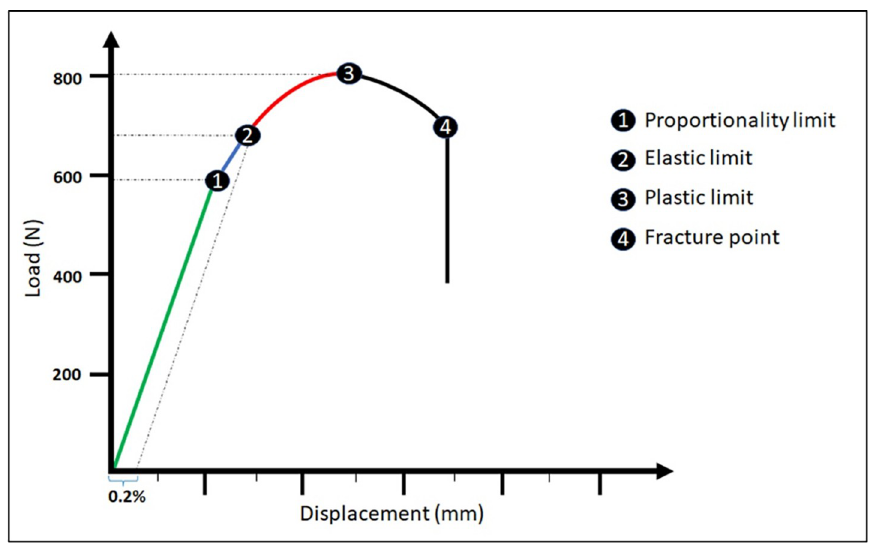
Fig 4. Graph demonstrating the limits of resistance that were evaluated in each set in each group.